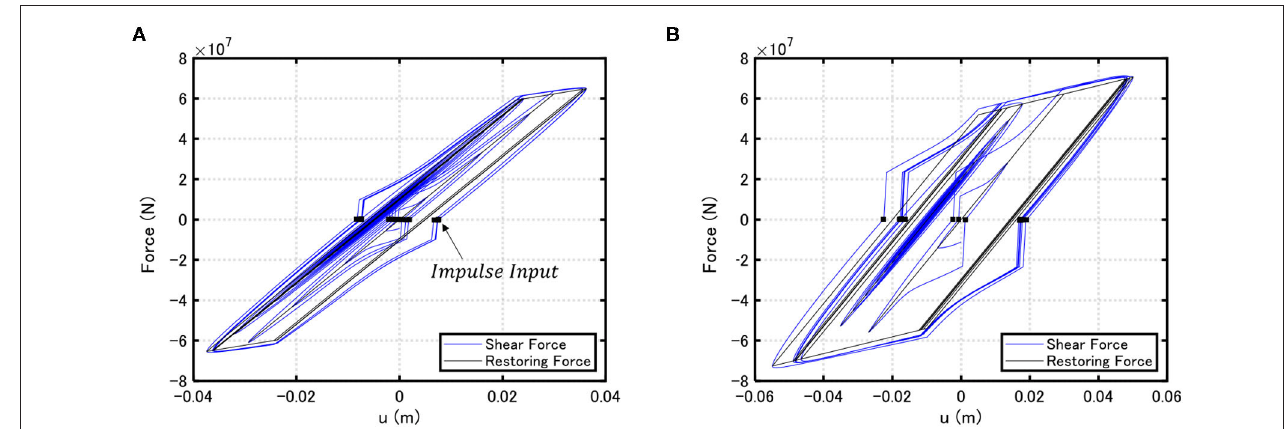
FIGURE 4 | Story shear force–interstory drift relation in the first story [restoring force (black) and restroing force with damping force (blue)] for 20-story building model. (A) V MI / V y = 2.0, (B) V MI / V y =